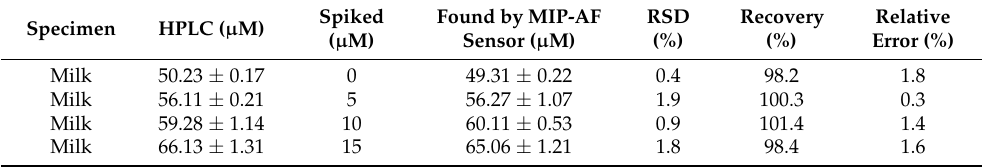
Table 3. Analyses of Trp in milk samples by the MIP-AF sensor and HPLC method ( n = 5).